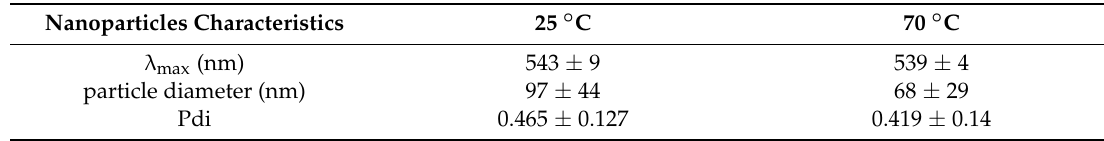
Table 2. The average PD, λ max, and polydispersity index (Pdi) values obtained from all the plant extracts at 25 ◦ C and 70 ◦